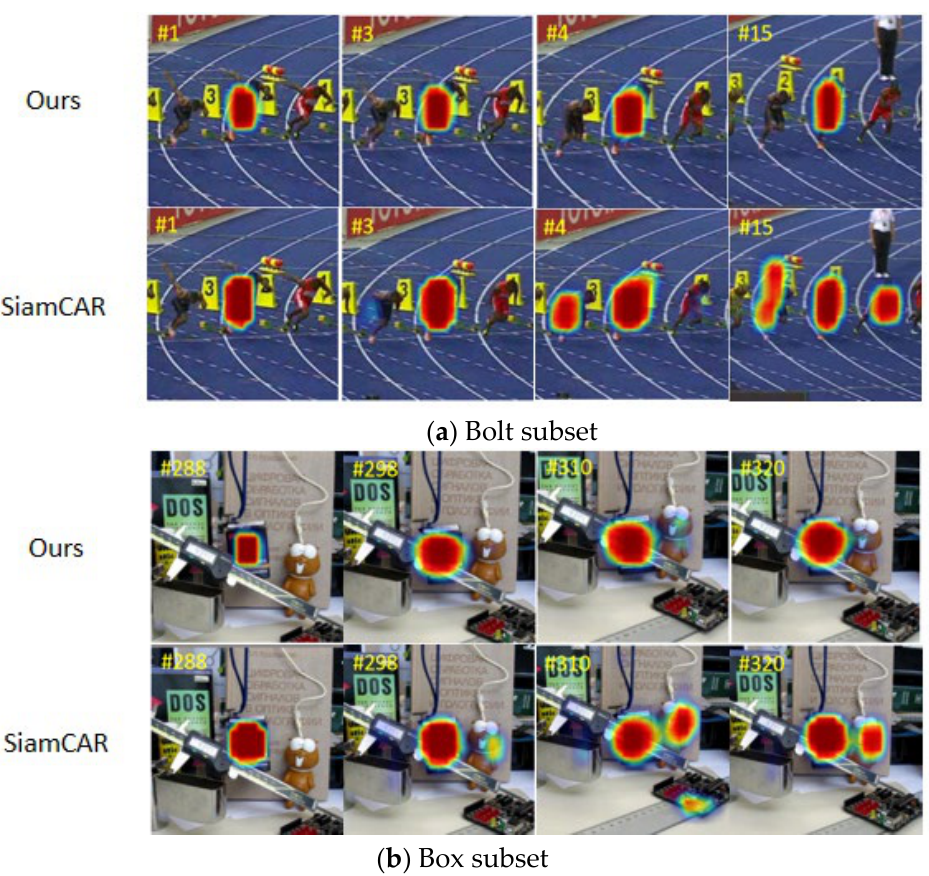
Figure 9. Heat map comparison between ours and SiamCAR.